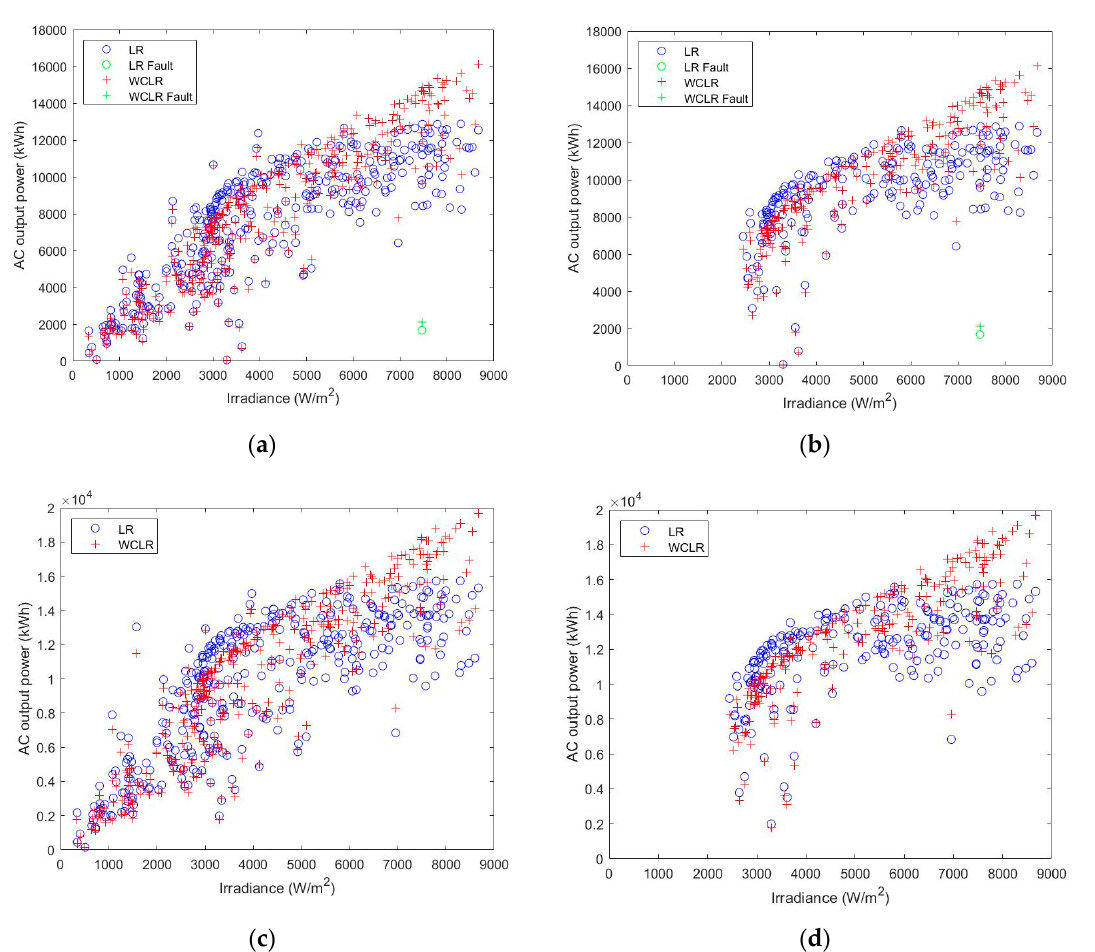
Figure 2. The Linear Regression (LR) and WCLR of each plant and its conditions. ( a ) Plant A (2 MW); ( b ) Plant A (2 MW)—CI > 0.5; ( c ) Plant B (2.3 MW); ( d ) Plant B—CI > 0.5. Table 2. Mean and standard deviation values of PR, PR (CI > 0.5), WCPR, WCPR (CI > 0.5)—Plant A.